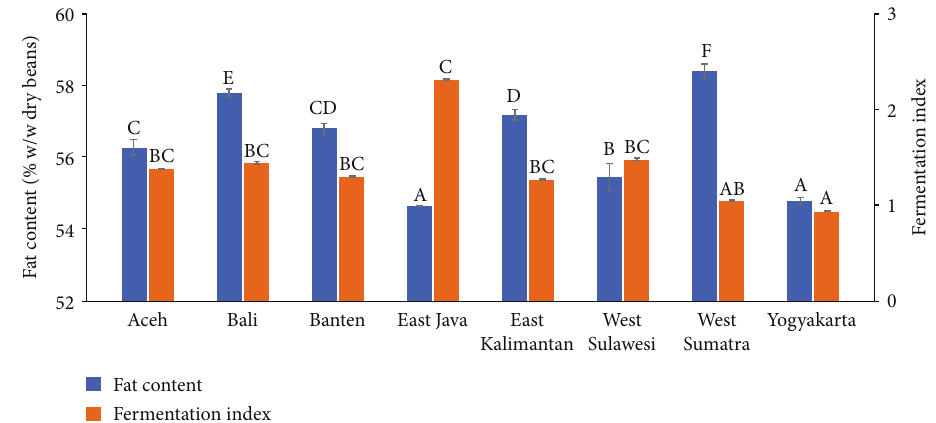
Figure 1: Fat content and fermentation indexes of cocoa beans samples from various regions of Indonesia. Bars represent standard deviation ( n = 3 ). Bars with the same letter in the same group showed that the values were not signi fi cantly di ff erent (blue bars based on one-way ANOVA and Tukey ’ s HSD tests, orange bars based on Kruskal-Wallis and Mann – Whitney ’ s tests at 95% con fi dence interval).